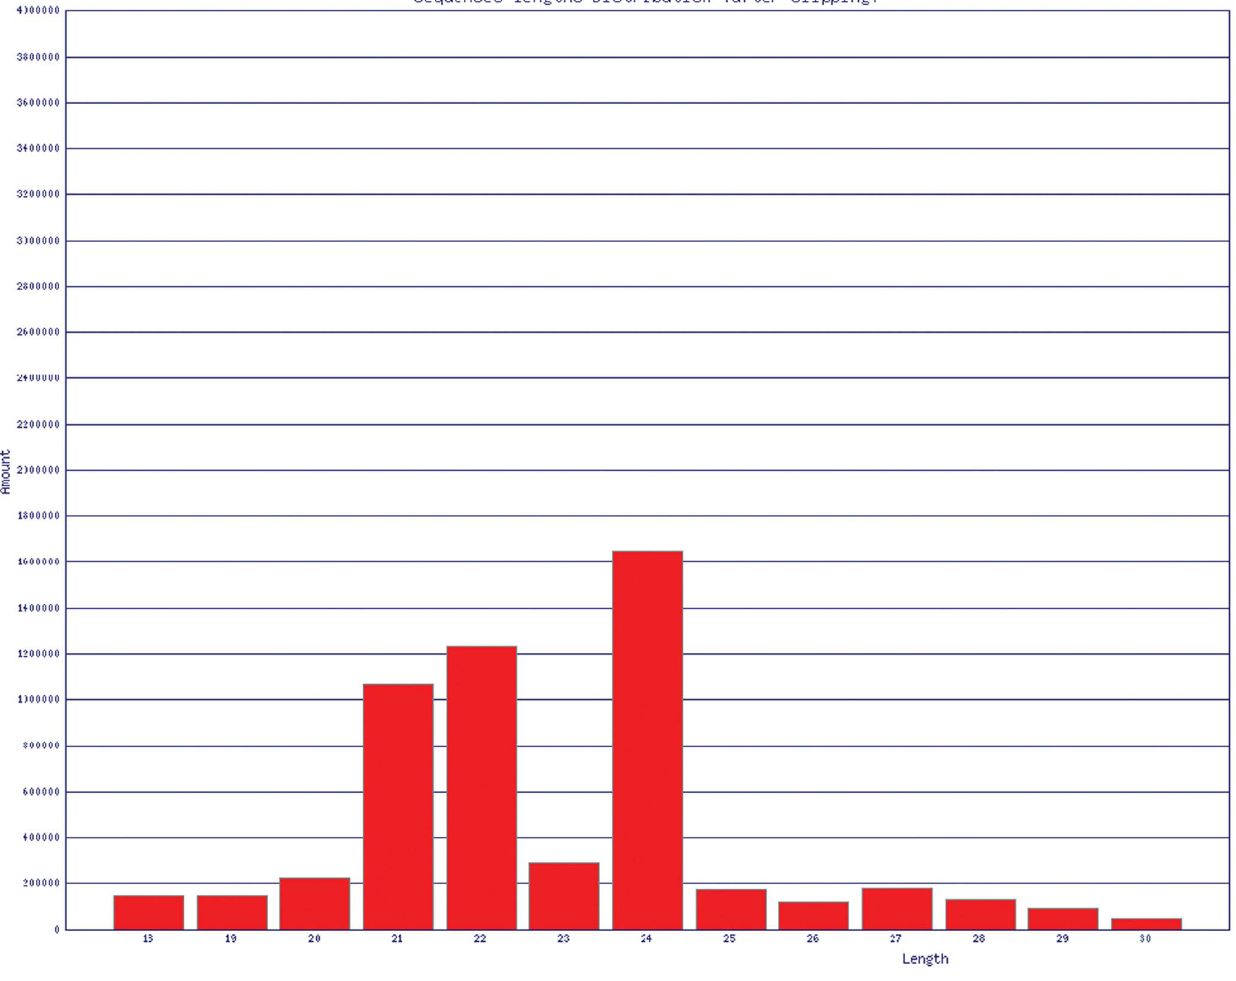
Figure 6. Sequence length distribution of small RNAs. doi:10.1371/journal.pone.0095428.g006 PLOS ONE |